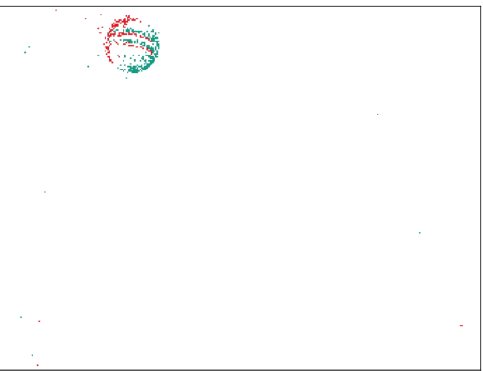
Figure 6. Example of an unprocessed recording of a ball with two stripes during free fall (animated in the digital version of this